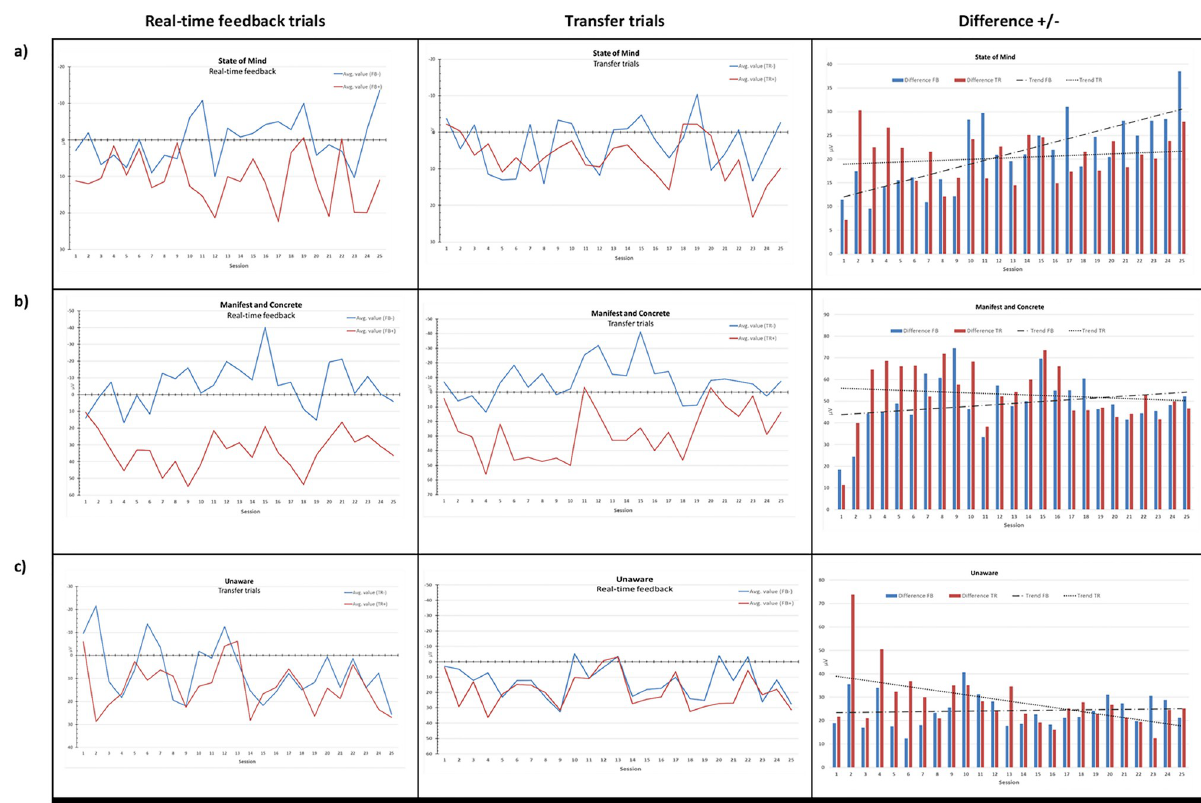
Fig 3. SCP regulation profiles. Graphs illustrating the performance during real-time feedback (FB)[left] and transfer (TR)[middle] trials. FB- and TR- indicates the performance during activations trials (i.e. increased negativity) and FB+ and TR+ indicated performance during deactivations trials (i.e. increased positivity). Difference +/- (right) shows the difference between activation trials (FB- & TR-) and deactivation trials (FB+ & TR+). Trend lines for FB and for TR are also shown. The average performance and average differences per session for participants in the “State of Mind” profile are shown in a), the “Manifest and Concrete” profile is shown in b), and the “Unaware” profile is shown in